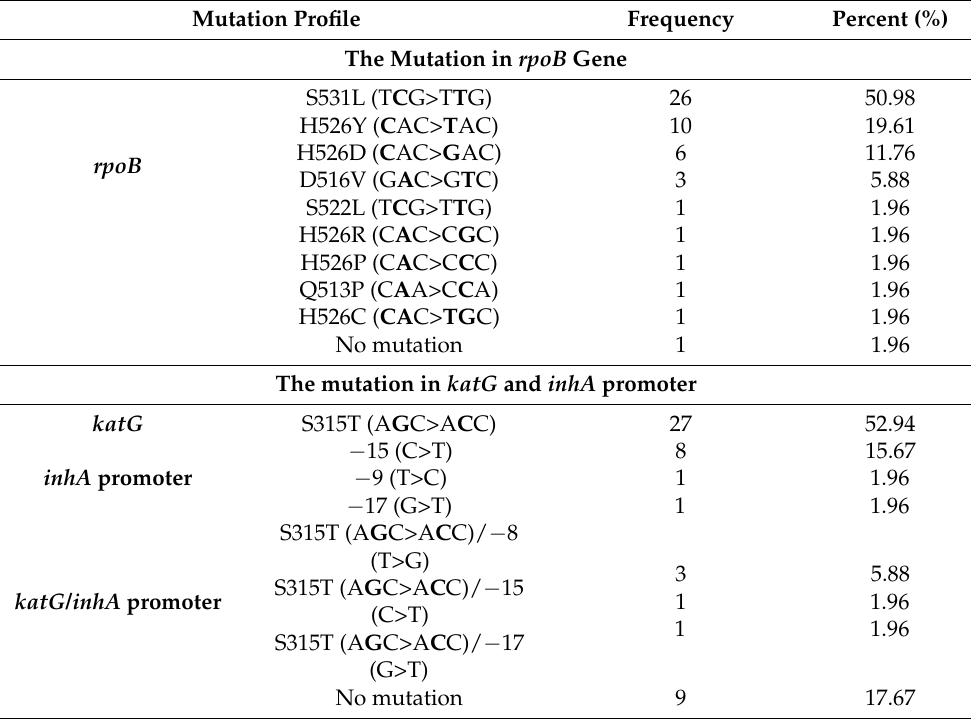
Table 1. The frequency of the rpoB , katG , and inhA promoter mutations among 51 multidrug-resistant Mycobacterium tuberculosis isolates in the northern Thailand. Mutation Profile